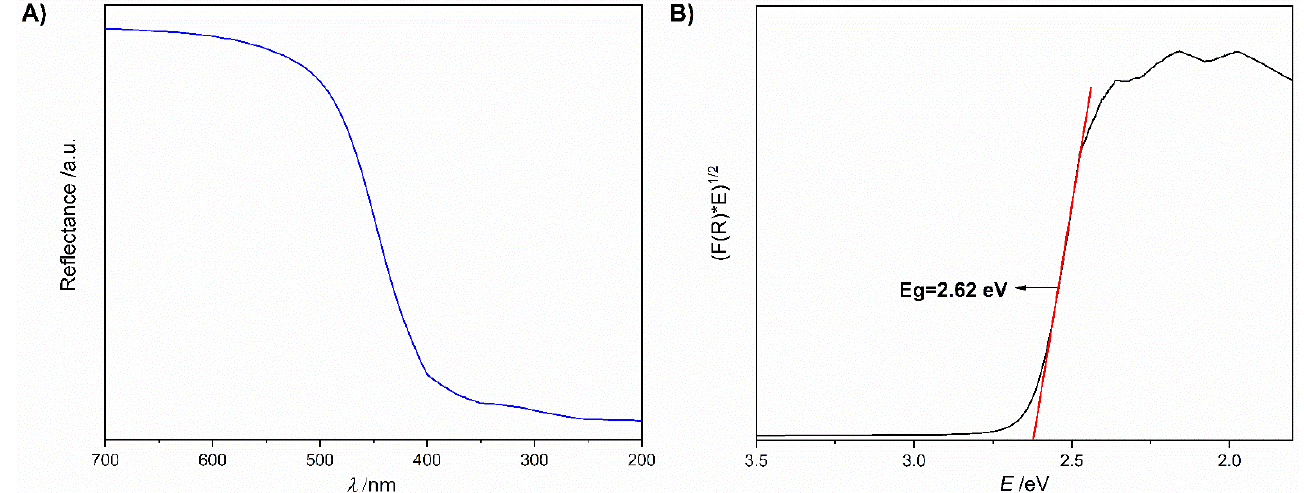
Figure 4. ( A ) UV-Visible diffuse reflectance spectra and ( B ) Kubelka–Munk transferred diffuse reflectance spectra of g -C 3 N 4 .